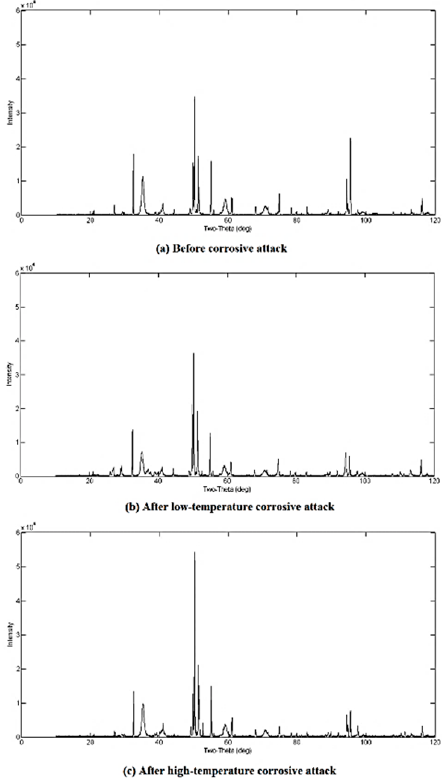
Figure A24. Qualitative XRD analysis of the surface of CS-A-Z ( a ) before corrosive attack, ( b ) after low-, and ( c ) high-temperature corrosive attack.